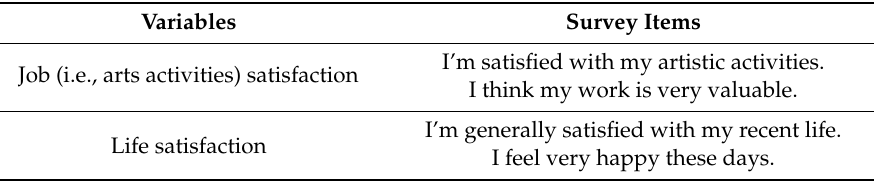
Table 2. List of dependent